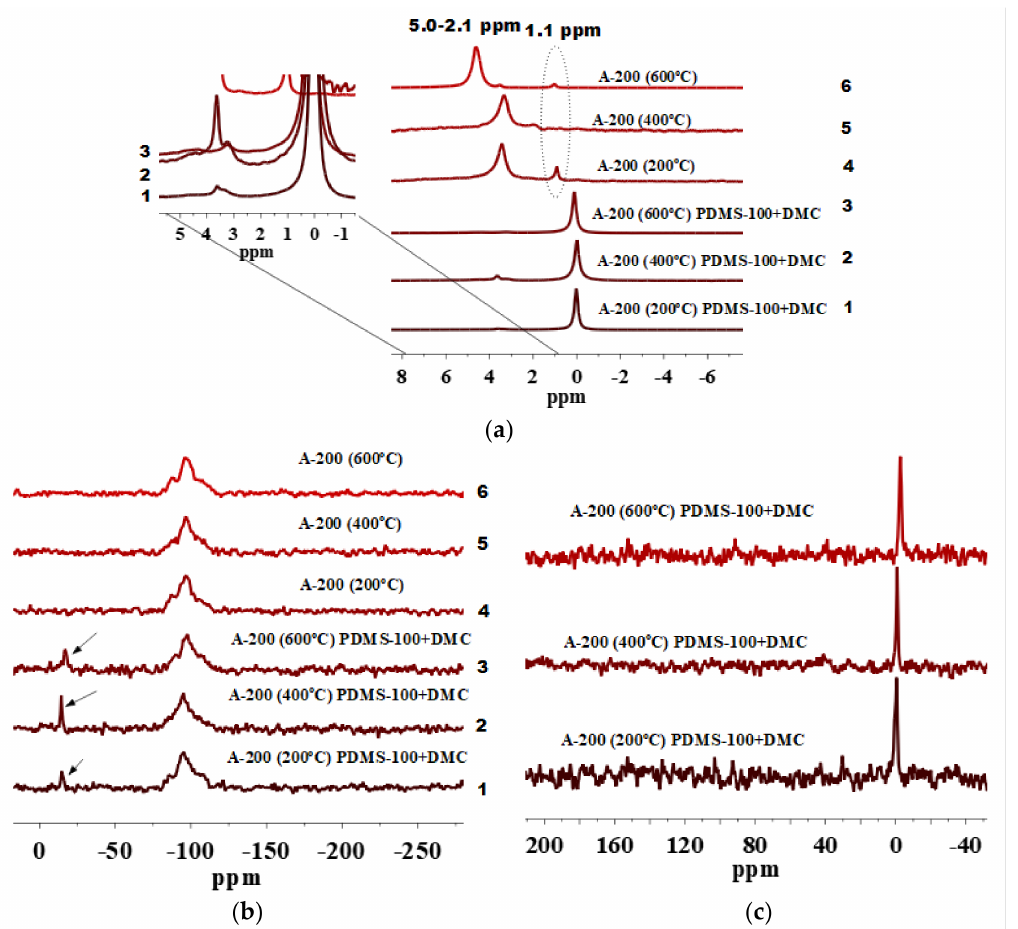
Figure 6. ( a ) 1 H MAS NMR, ( b ) 29 Si CP/MAS NMR, and ( c ) 13 C CP/MAS NMR spectra of A-200 preheated at 200, 400, and 600 ◦ C and modified by